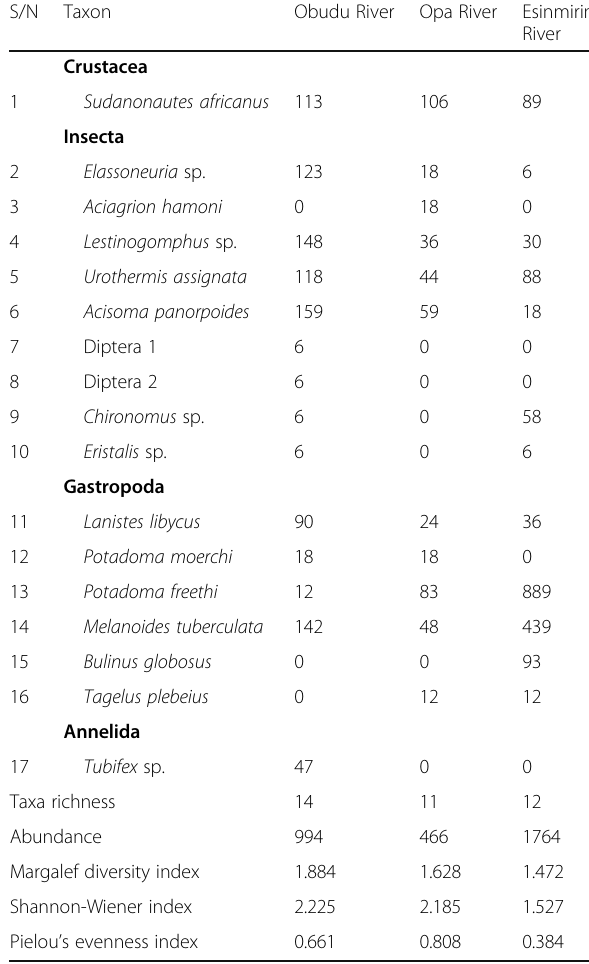
Table 3 Macroinvertebrate composition, distribution, and community structure in Opa Reservoir ’ s tributaries (September